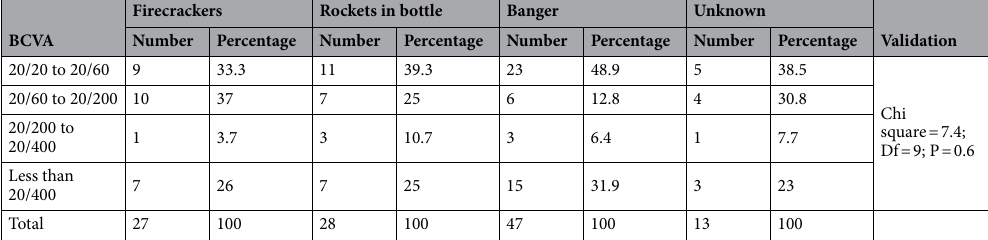
Table 2. Visual outcomes (BCVA) by the type of fireworks-related ocular injury. BCVA best corrected visual acuity.